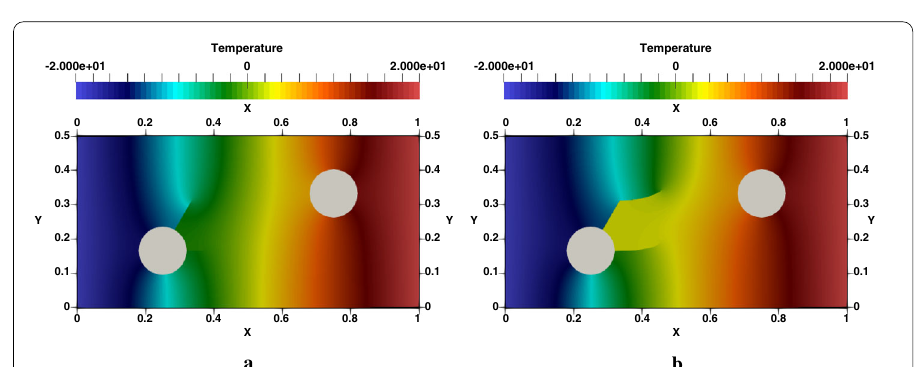
Fig. 26 Crack growth in plate with two circular holes and multiple cracks: Temperature profile; a initial state, b 13 (cid:14) a